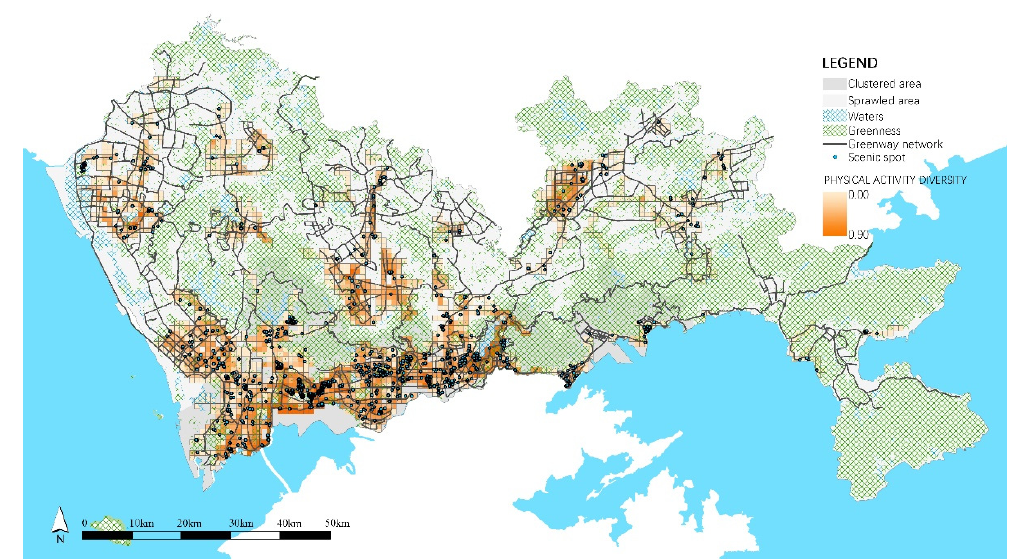
Figure 4. Spatial distribution of greenway network and scenic spots.